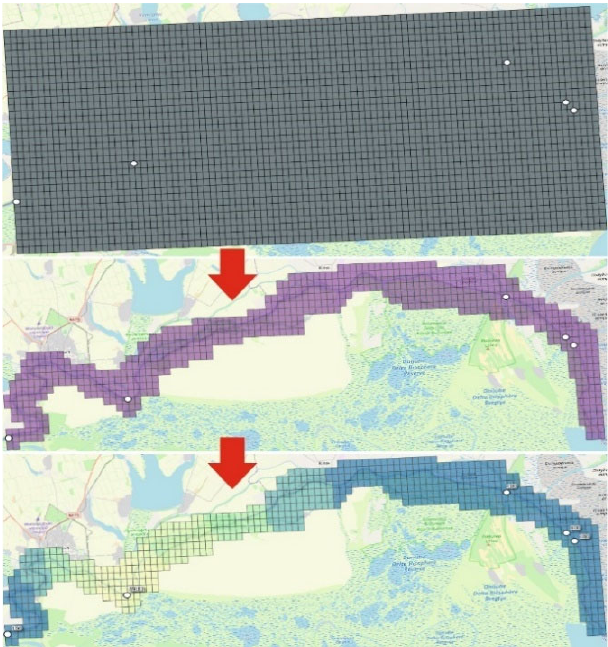
Figure 3. Grid processing steps: up—grid creation for the whole area, middle—altering the grid to the river flow, down—graduated quantile classes of the interpolated data.